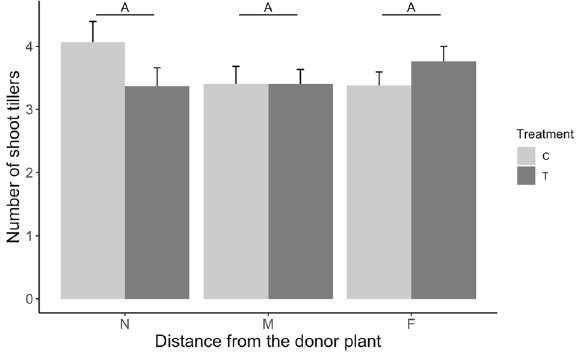
Figure 4. Effect of location of leachate collection on number of shoot tillers of receiver plants. T = leachates from nematode-infected plants, C = leachates from control plants. N (5–15 cm), M (15–25 cm), F (25–35 cm) indicates different distances away from the leachate donor plants. Bars are means ± SE (n = 30) across all leachate collection times. The same letter above the means indicate no significant differences between distances based on Tukey multiple comparison test.